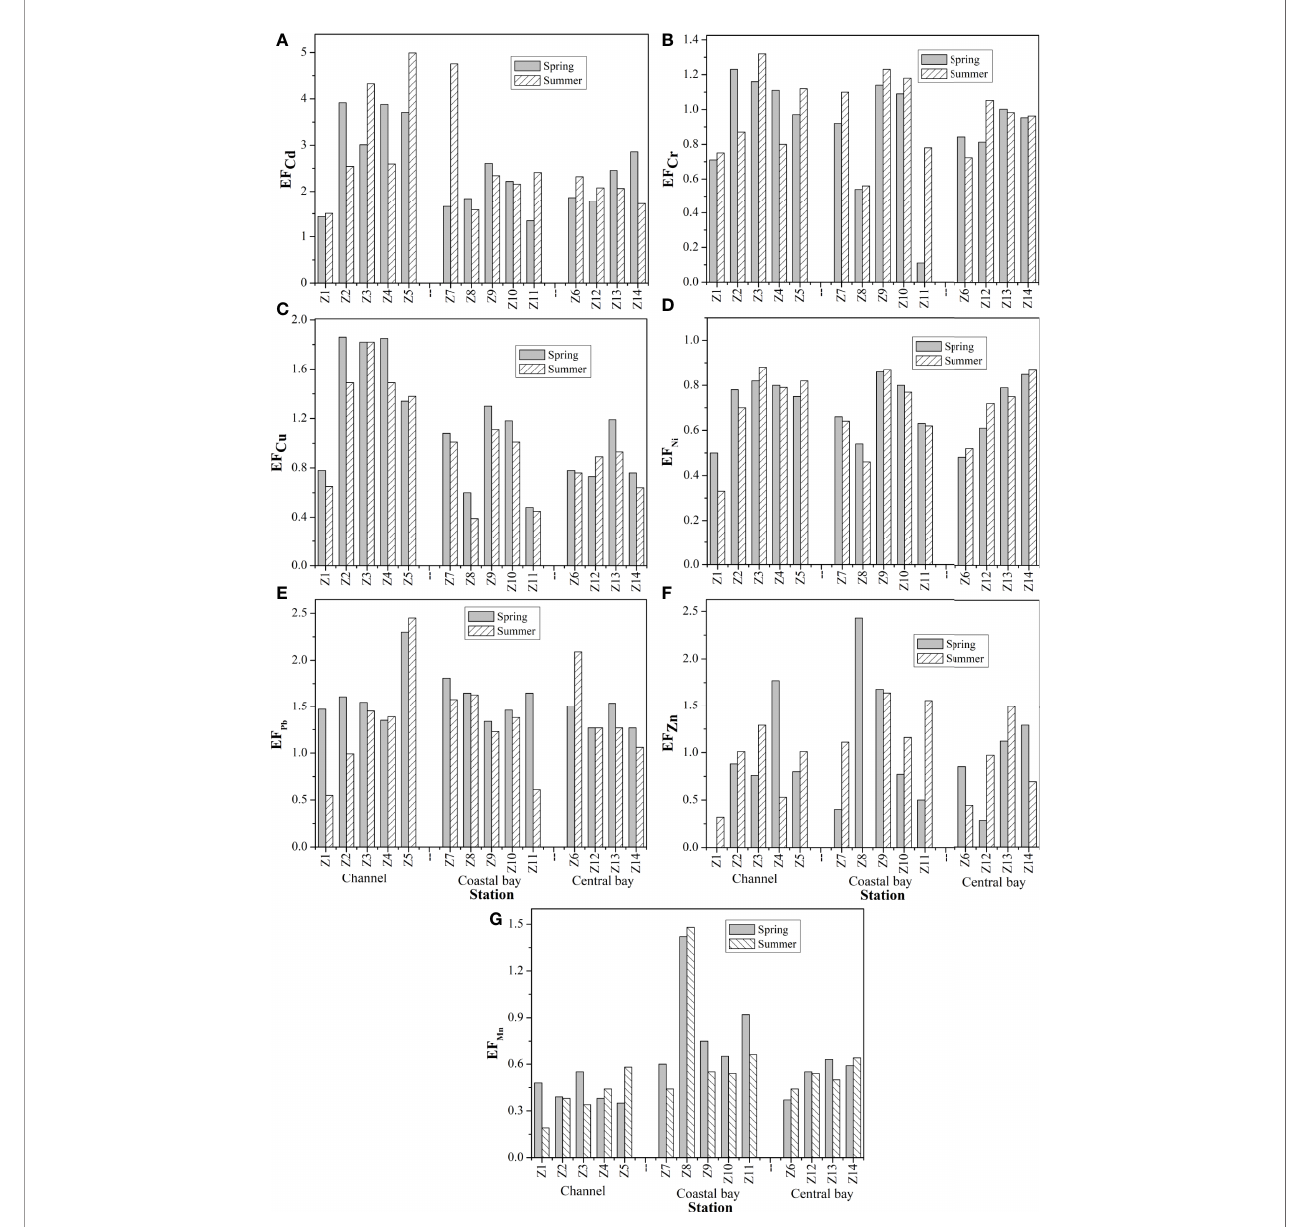
FIGURE 5 | Distributions of enrichment factor (EF) for Cd (A) , Cr (B) , Cu (C) , Ni (D) , Pb (E) , Zn (F) and Mn (G) in surface sediments of Zhanjiang